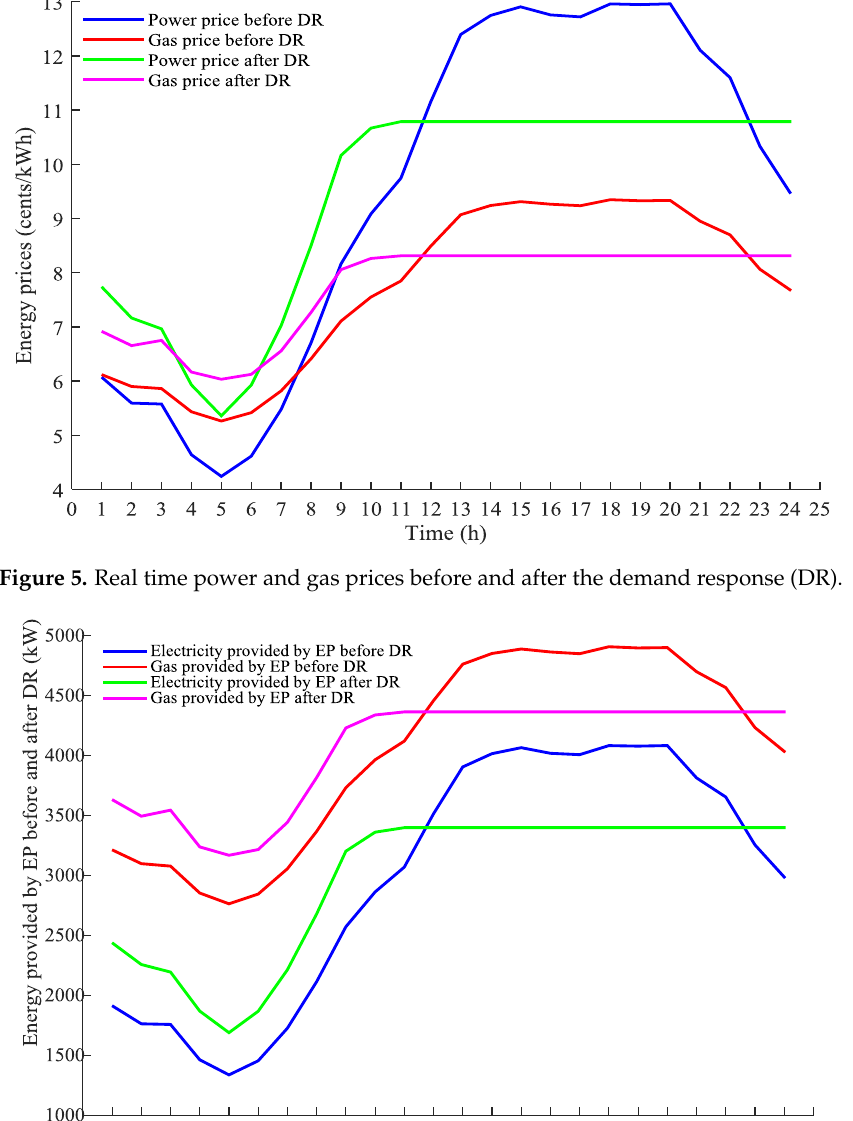
Figure 7. Hourly power demands of all EHs before and after DR.